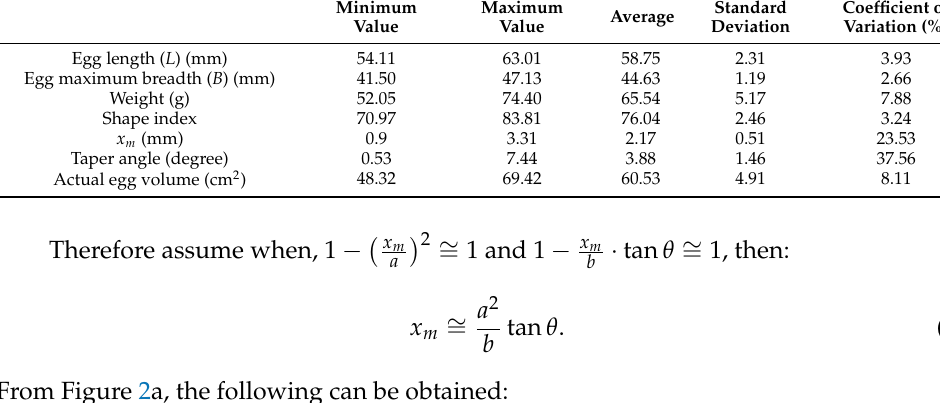
Standard Coefficient of Deviation Variation (%)